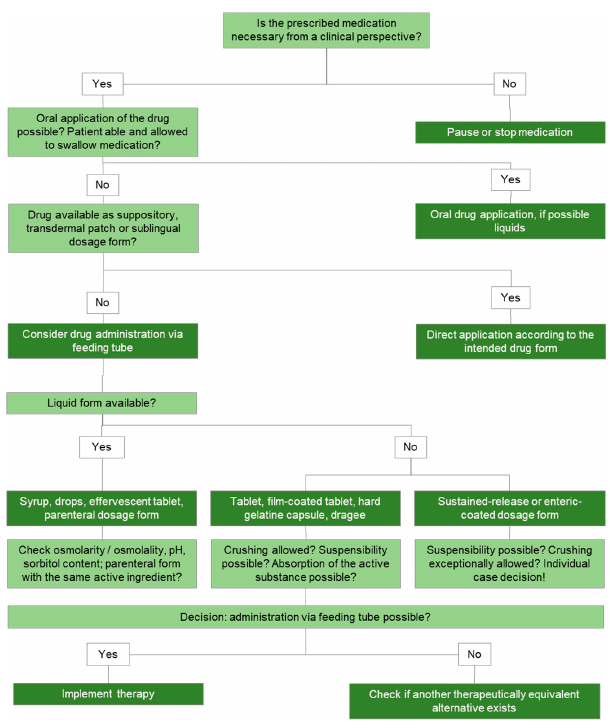
Figure 2. Algorithm for the evaluation of drug administration via feeding tube.